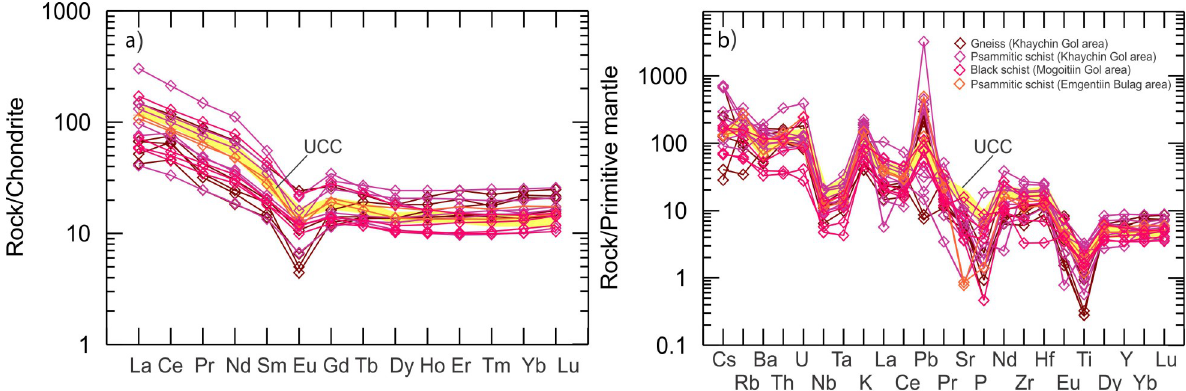
Fig. 11. Chrondrite-normalized REE patterns and primitive mantle-normalized trace element spider diagrams for of black schist, gneiss and psammitic schists from the Mogoittin Gol, Khaychin Gol and Emgentiin Bulag areas. Chondrite- and primitive mantle-normalization values are from Sun and McDonough (1989). UCC data from Taylor and McLennan (1985) are plotted for comparison, respectively. UCC, Upper continental